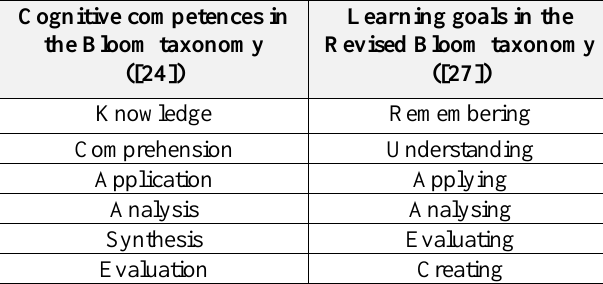
.Table 1: Original and revised Bloom taxonomies Cognitive competences